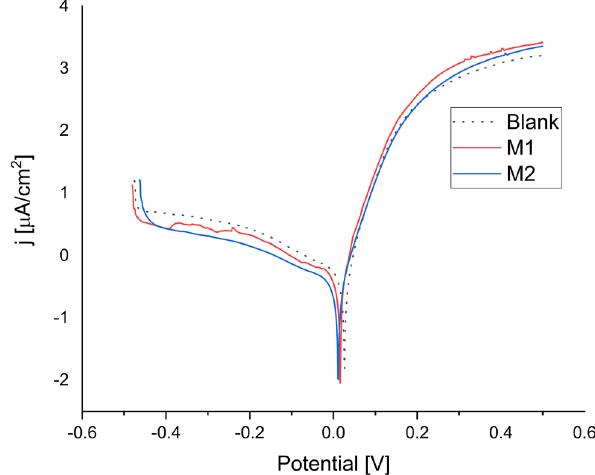
Figure 1: Semilogarithmic polarization plots of the copper electrode in a 0.1 M H 2 SO 4 ( 70:30 water:ethanol ) aqueous solution with and without the presence of 0.001 mol/dm 3 : M1 and ( b ) M2 . Reference SCE. v = 1 mV/s.